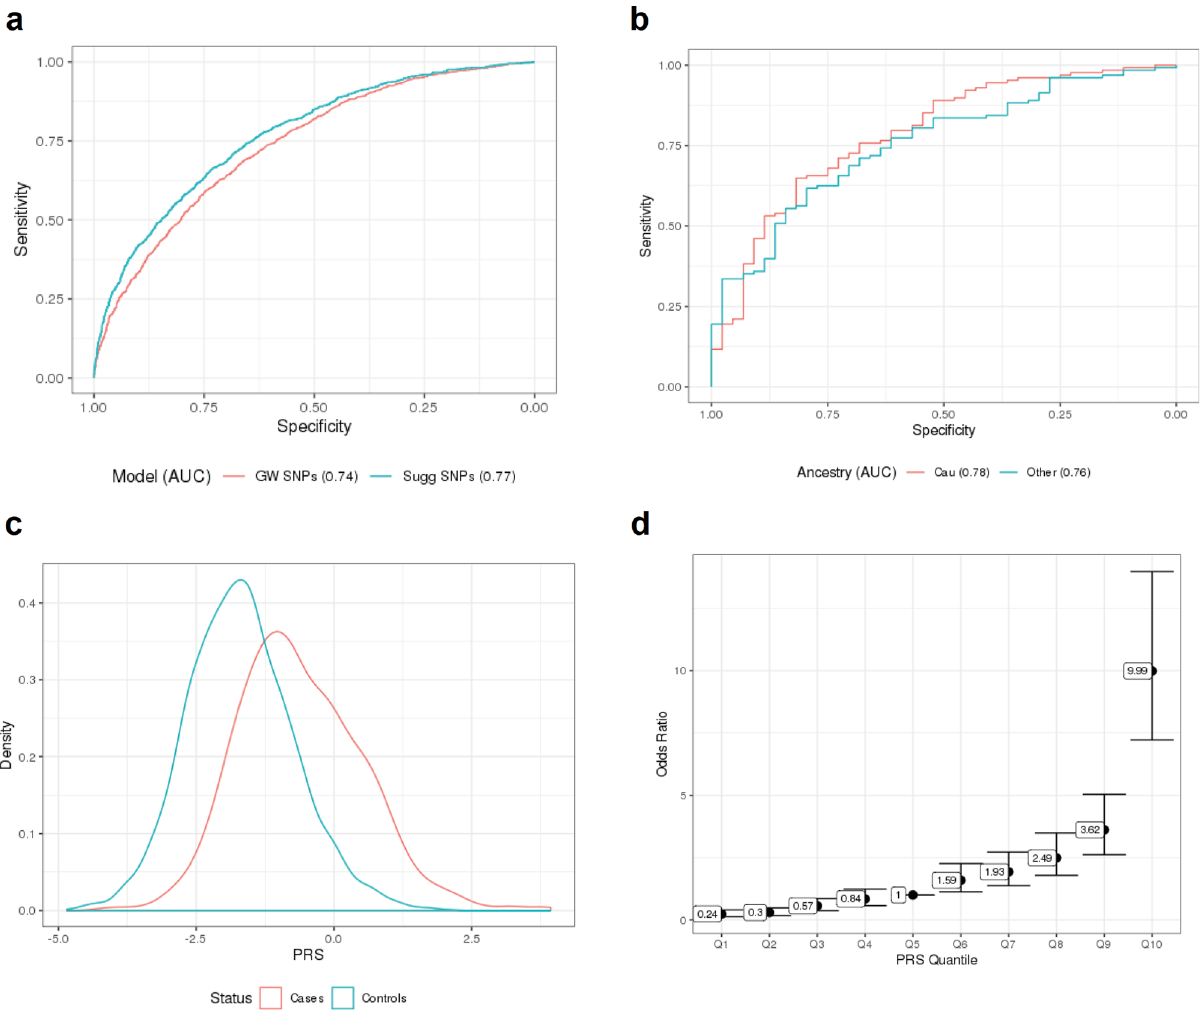
Fig. 4 Prediction of MacTel status using polygenic risk score (PRS). a ROC curves of the two tested PRSs. Area under the ROC curve (AUC) is reported in the fi gure legend. b Comparison of ROC curves for prediction accuracy among European and non-European. Area under the ROC curve is reported in the fi gure legend. c Density plot comparing PRS distribution of between cases and controls. d Odds ratio for magnitude MacTel Risk comparing deciles to the median